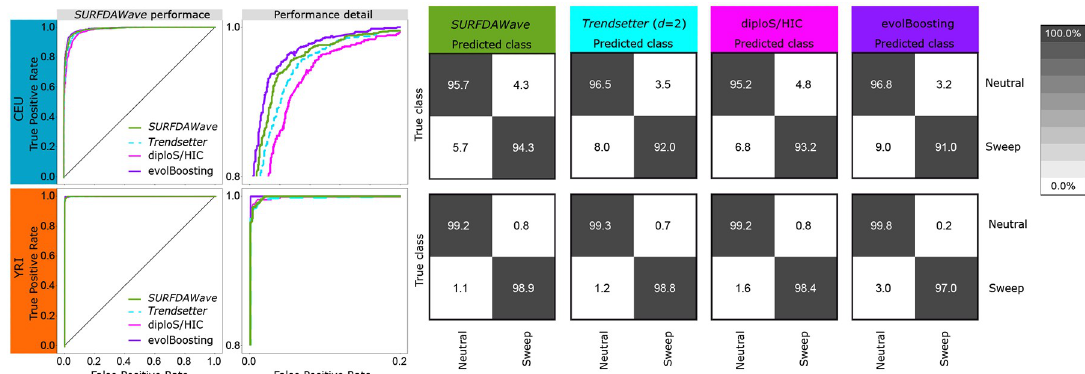
Fig 2. SURFDAWave classifier performance compared to Trendsetter , diploS/HIC, and evolBoosting when differentiating between sweeps and neutrality and trained and tested with simulations based on CEU (top row) and YRI (bottom row) demographic history. (Left) Power to differentiate between sweep and neutrality by comparing the probability of a sweep under sweep simulations with the same probability in simulations of neutrality including zoomed in region between 0.0 and 0.2 on the x -axis and 0.8 and 1.0 on the y -axis. (Right confusion matrices) Confusion matrices comparing classification rates of the methods. SURFDAWave applied using Daubechies’ least-Asymmetric wavelets to estimate spatial distributions of summary statistics with γ penalties and level chosen through cross validation (see Training the models ). Summary statistics ^ p , H 1 , H 12 , H 2 / H 1 , and frequency of the first, second, third, fourth, and fifth most common haplotypes used by both Trendsetter and SURFDAWave .